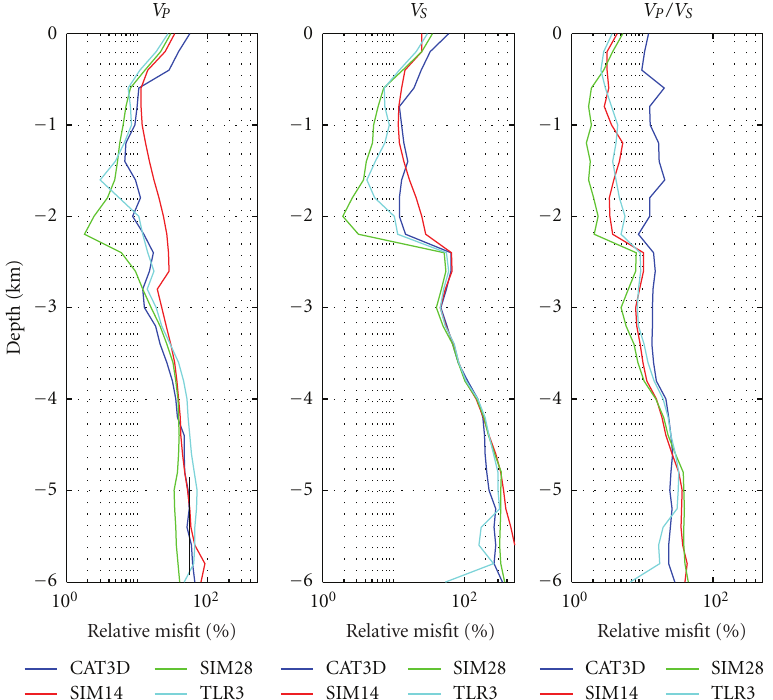
Figure 26: Mean deviation of the inverted velocity models and V P /V S ratio from the true ones as a function of depth. Deviation is calculated for each method as the weighted rms di ff erence between the true and inverted models along horizontal planes, using the resolution matrix as a weight. Note that a logarithmic scale is used to represent the quite large dynamics of the values